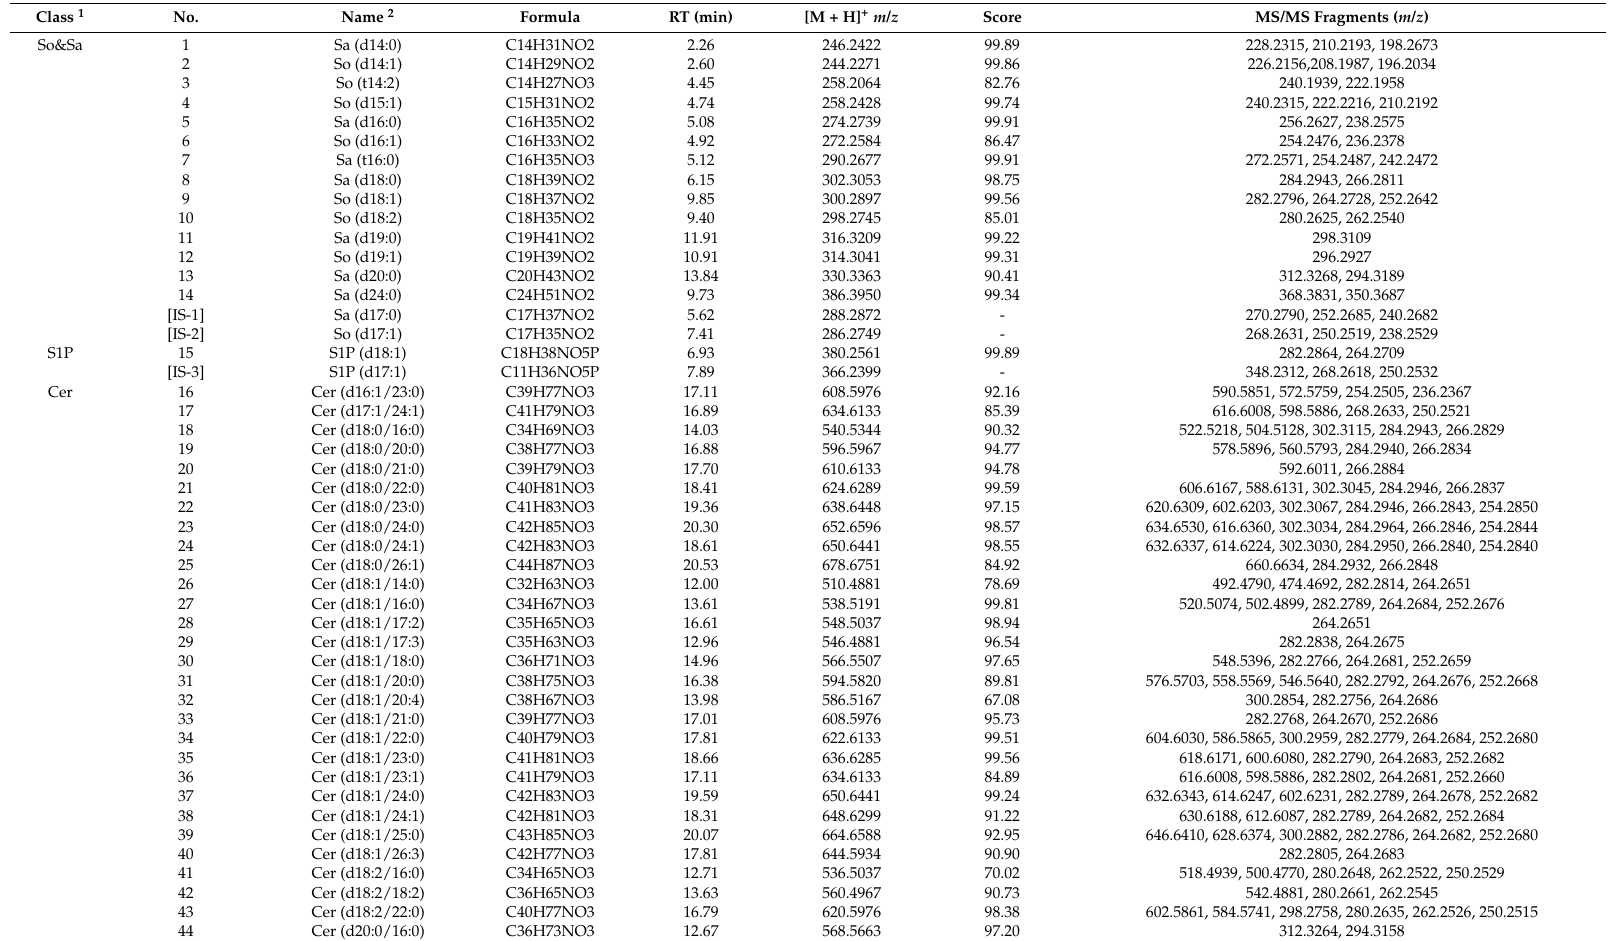
Table 1. Identification of SPLs in rat serum by using